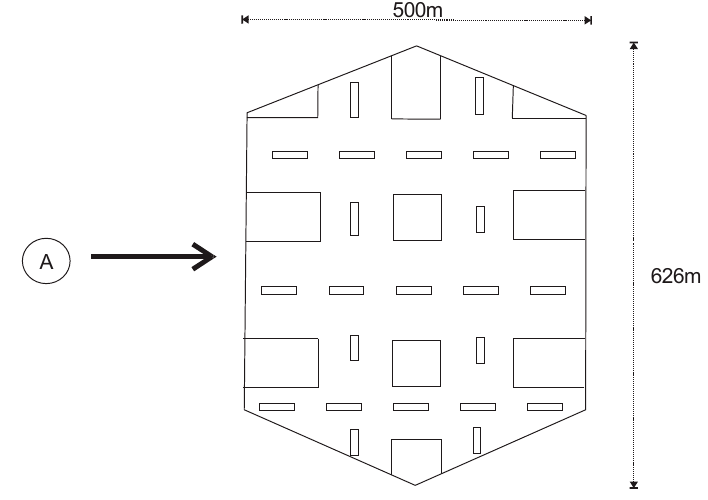
Figure 2. Physical location of a city represented as a